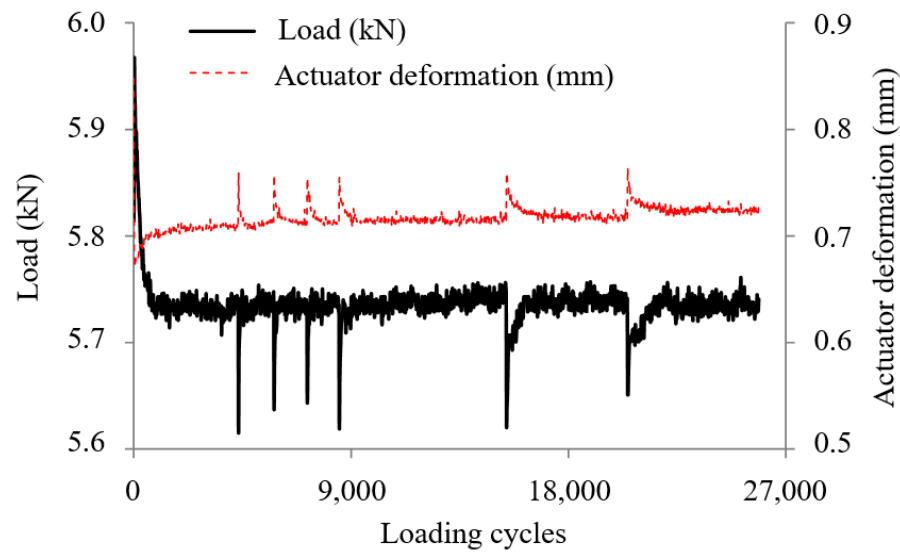
Figure 12. Displacement curve of loading point of composite beam under stress ratio 0.5.